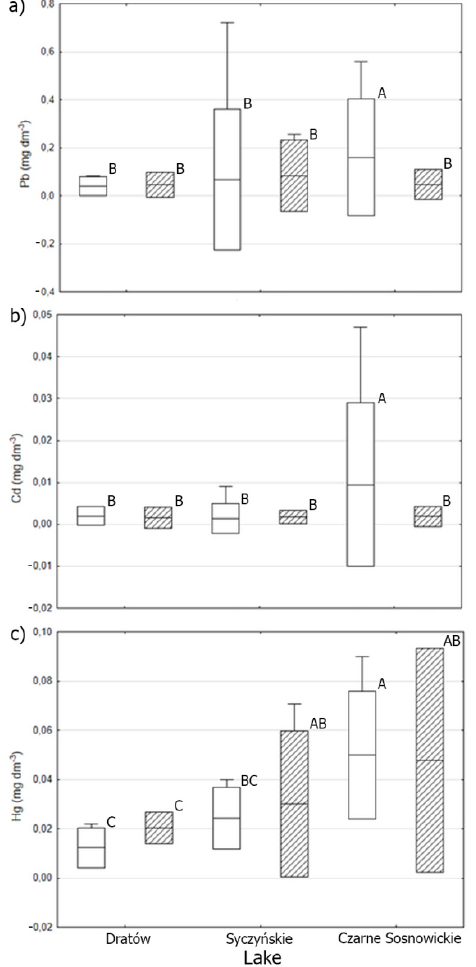
Figure 2. The concentration of Pb ( a ), Cd ( b ), and Hg ( c ) in muscles (in mg kg − 1 ) of non-predatory fish (box without pattern) and predatory fish (box with pattern) in studied lakes; explanation of graphics: whiskers—minimal and maximal values, line—mean value, and box—standard deviation. The different letters on the box—differences are statistically